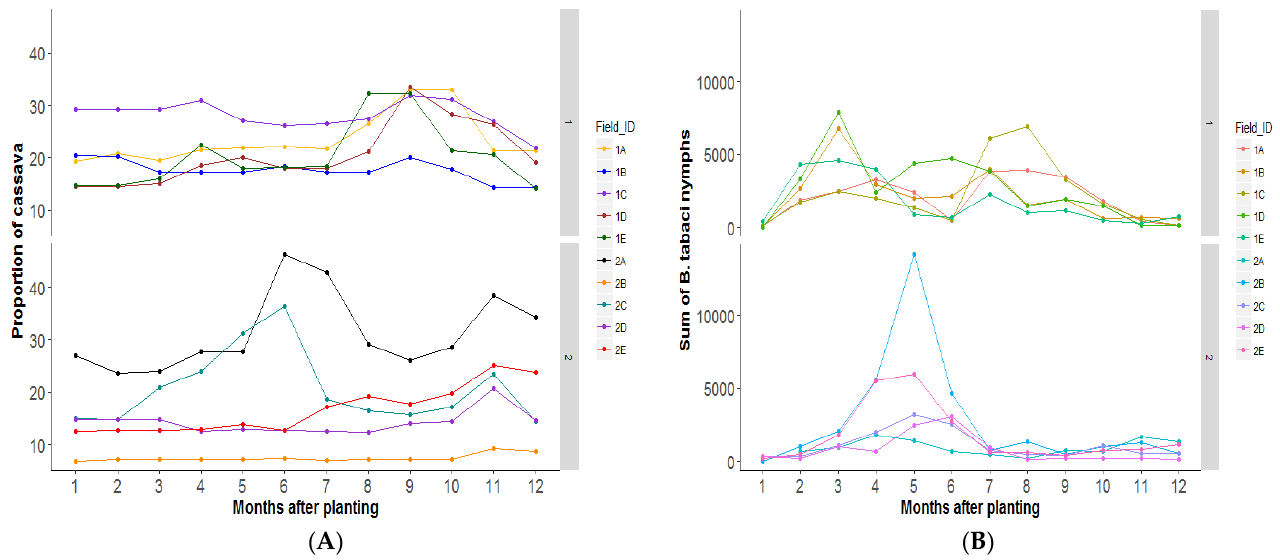
Figure 3. ( A ) Temporal changes in area planted with cassava in different landscapes in season 1 (March–February) and season 2 (August–July); ( B) corresponding temporal changes in Sub-Saharan Africa 1 (SSA1) Bemisia nymph species abundance on cassava in the same landscapes in the two